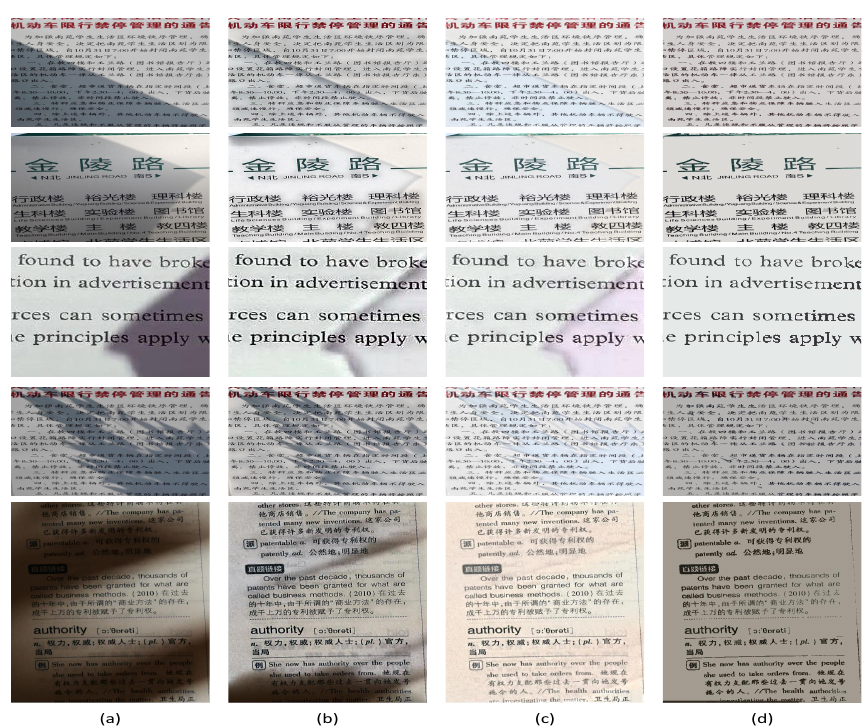
Figure 7. The visual comparisons of some state-of-the-art methods for the proposed OSR_NG dataset. ( a ) the input images, ( b ) the results of [11], ( c ) the results of [24], ( d ) our